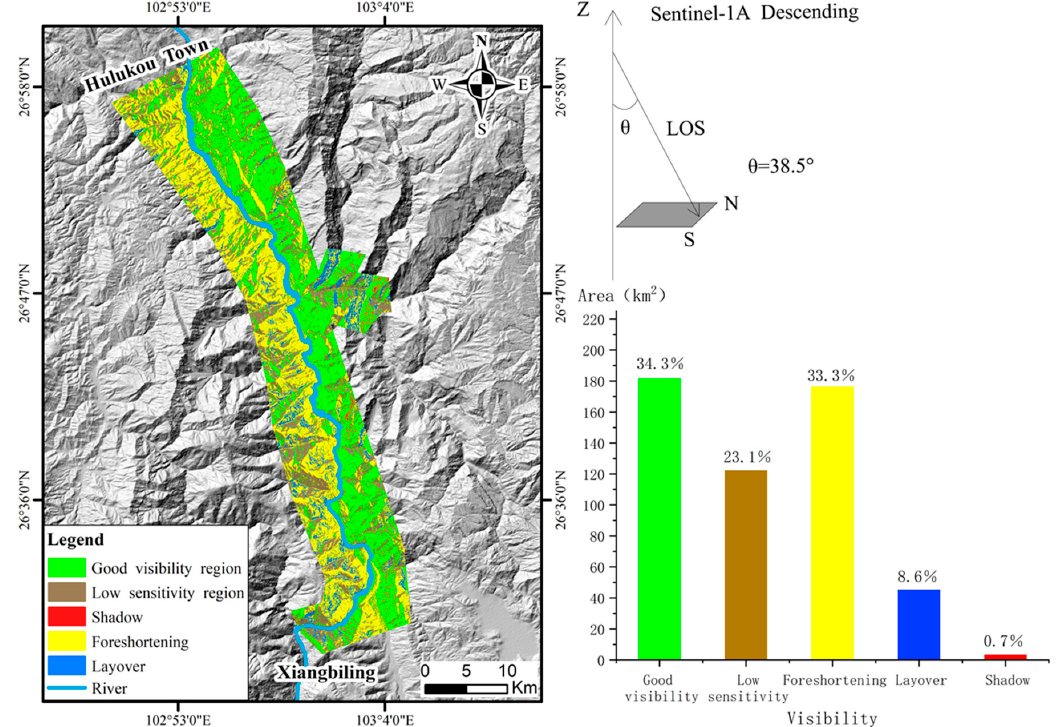
Figure 13. Visibility results of sentinel-1A descending data in the study area.